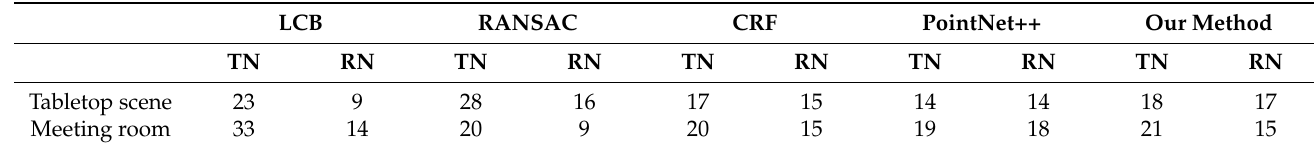
Table 4. The quantitative results of Figure 15.